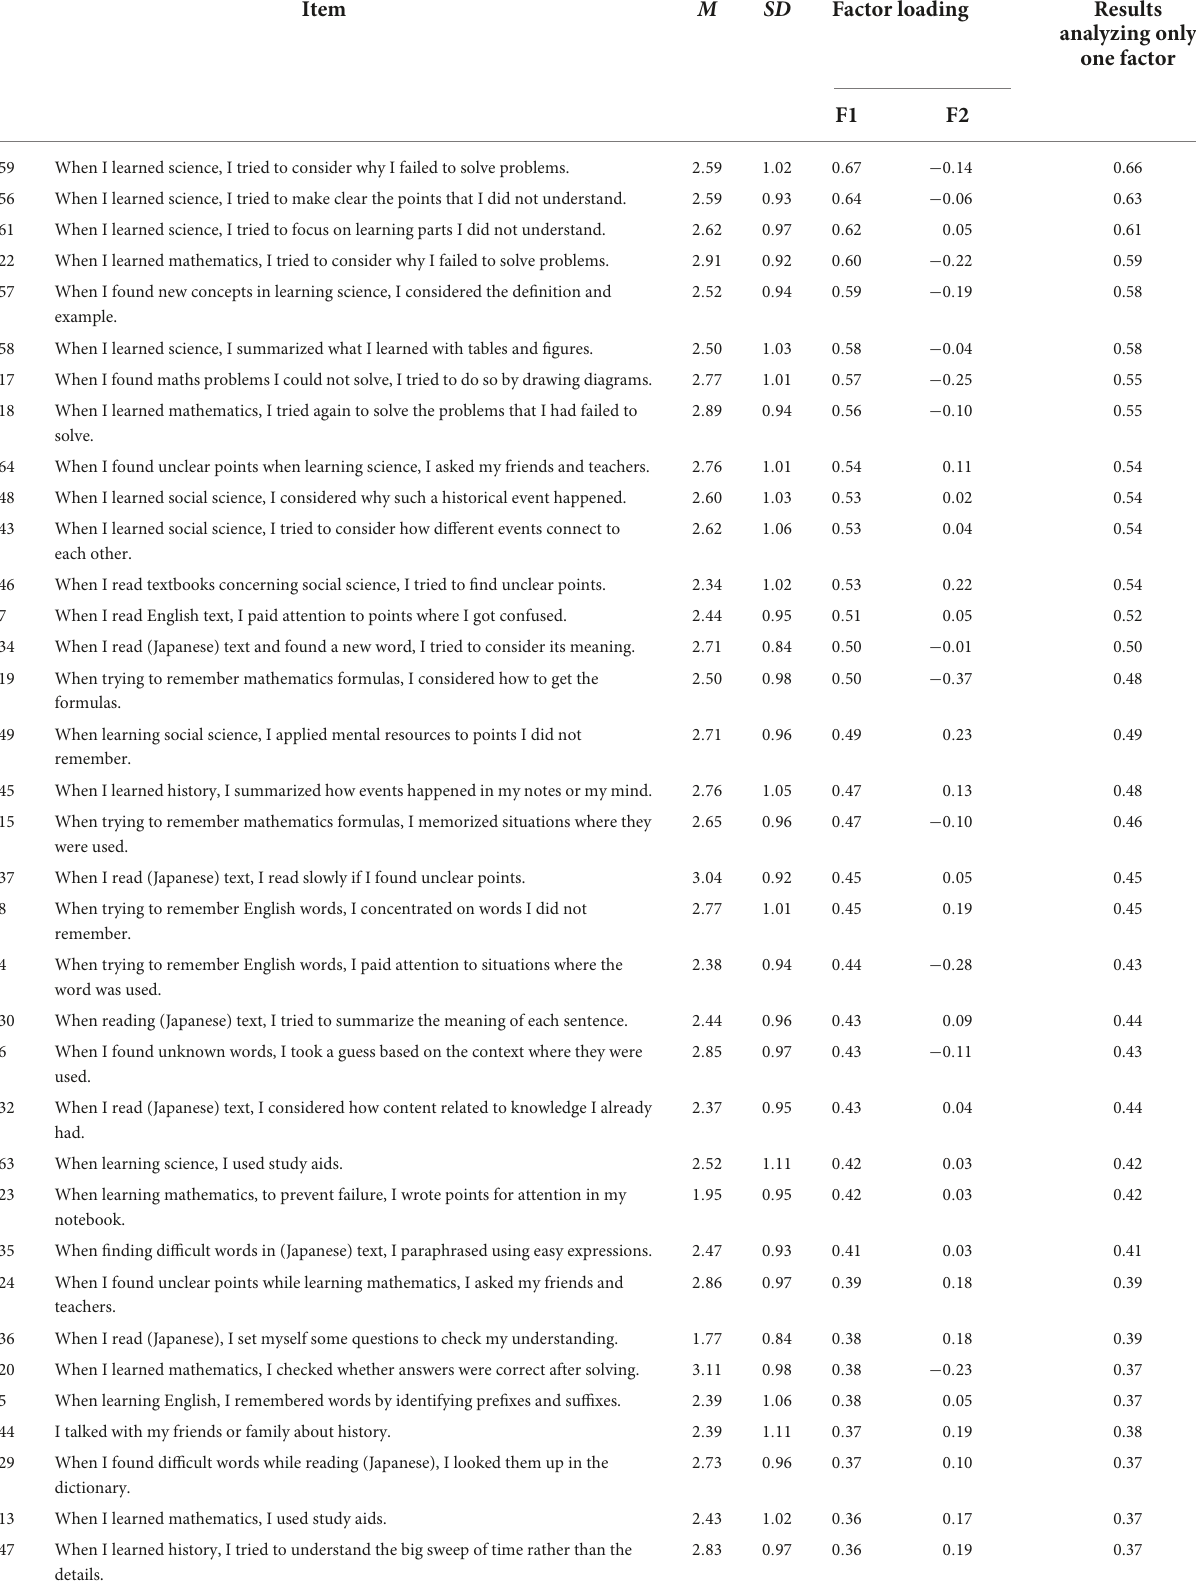
TABLE 3 Results of factor analysis and basic statistics. Item M SD Factor